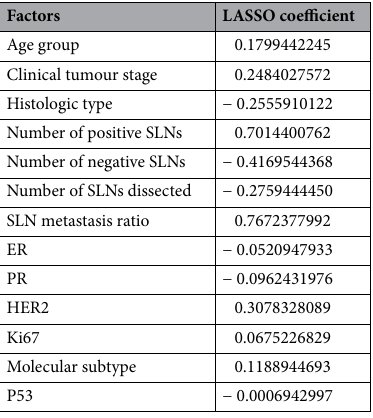
Table 4. Regression coefficients of the 13 most powerful factors identified by the LASSO regression analysis.